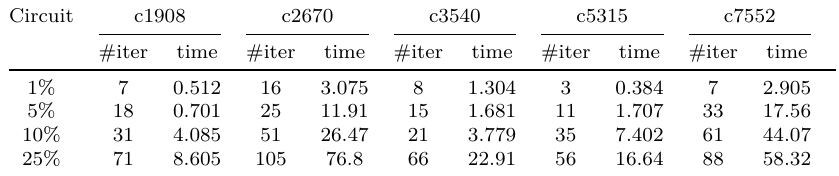
Table 7: Execution Time and the Number of Iterations of Accelerated Lazy SMT Attack (AccSMT) (Attack Mode 4) on SARLock + IOLTS’14 for finding K 1 (Traditional